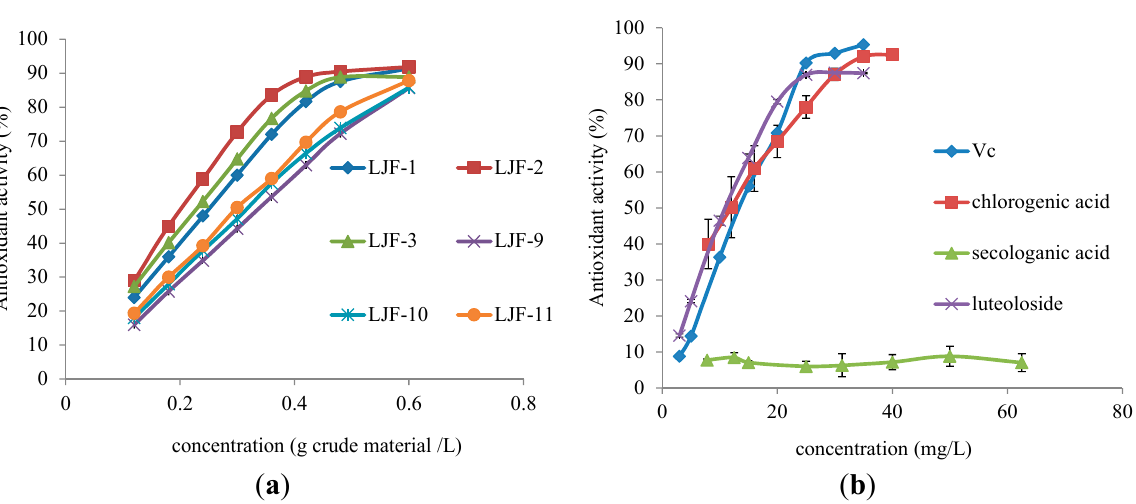
Figure 4. The antioxidant capability of sulfur-fumigated samples, sun-dried samples and reference compounds (n = 3). ( a ) The percentage of free radical scavenging of LJF samples at concentrations of 0.12, 0.18, 0.24, 0.30, 0.36, 0.42, 0.48 and 0.60 g crude material/L. ( b ) The percentage of free radical scavenging of reference compounds. The concentration was as follows: 3, 5, 10, 15, 20, 25, 30, 35 mg/L for Vc and luteoloside ( 17 ); 8, 12, 16, 20, 25, 30, 35, 40 mg/L for chlorogenic acid ( 3 ); and 7.8, 12, 15, 25, 31, 40, 50, 62 mg/L for secologanic acid ( 6 ).